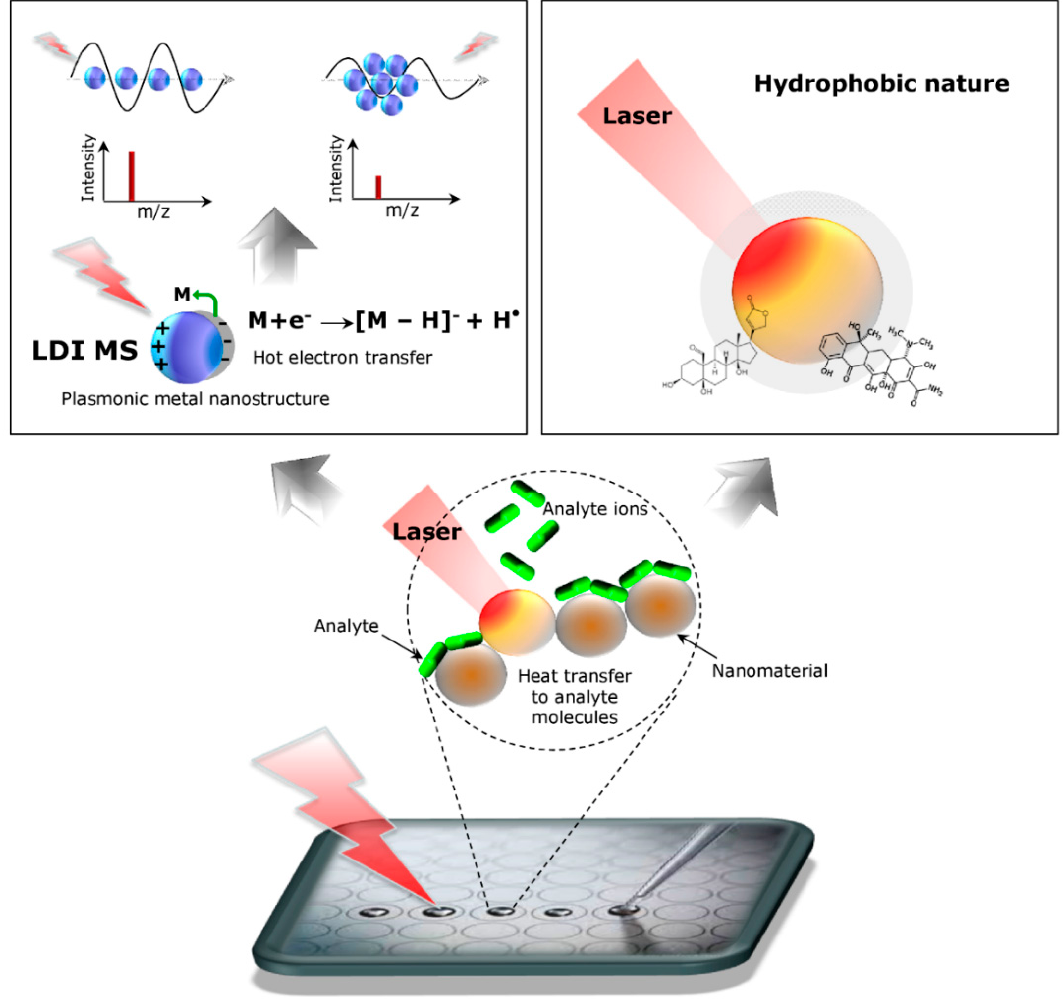
Figure 2. Mechanism of ionization in nanostructure-assisted laser desorption/ionization (NALDI).